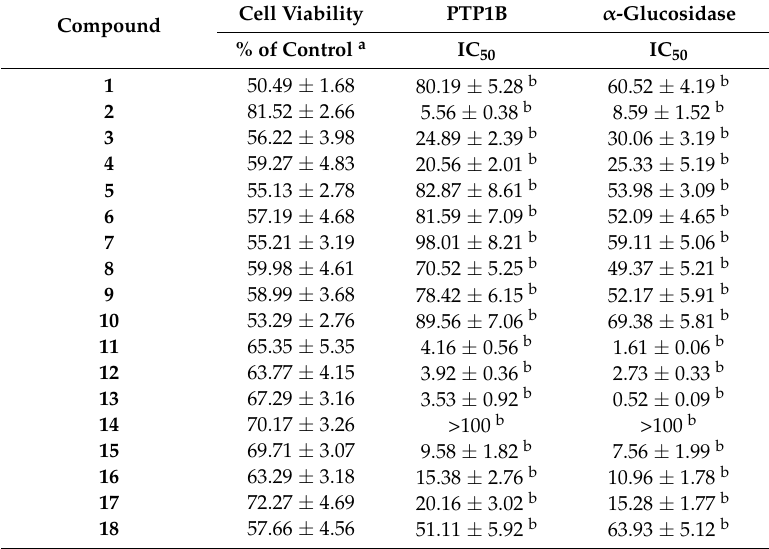
Table 2. Cell viability and inhibitory activities of extracts and isolated compounds. PTP1B, protein tyrosine phosphatase 1B.